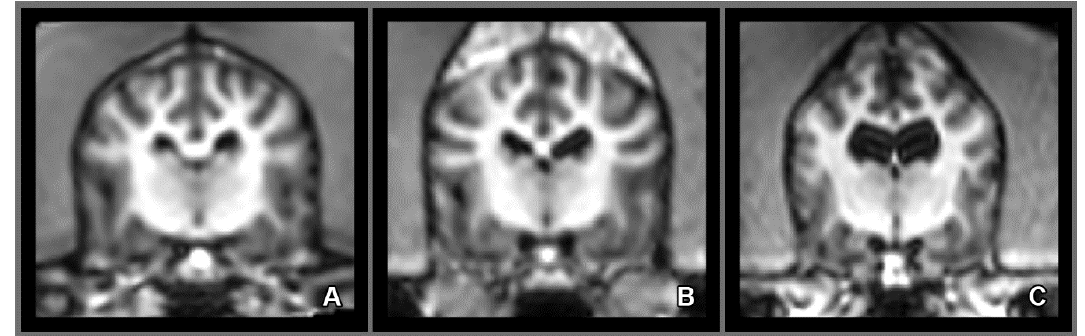
Figure 6. Baseline magnetic resonance (MR) images of three tested dogs. Mildly ( A ), moderately ( B ) and extremely enlarged ( C ) lateral ventricles are presented. Table 1. Ventricle volumes (left and right) of the seven dogs presented individually and in sum. The enlargement is expressed in percentage comparing volume measured at the 1st and the 2nd scan.